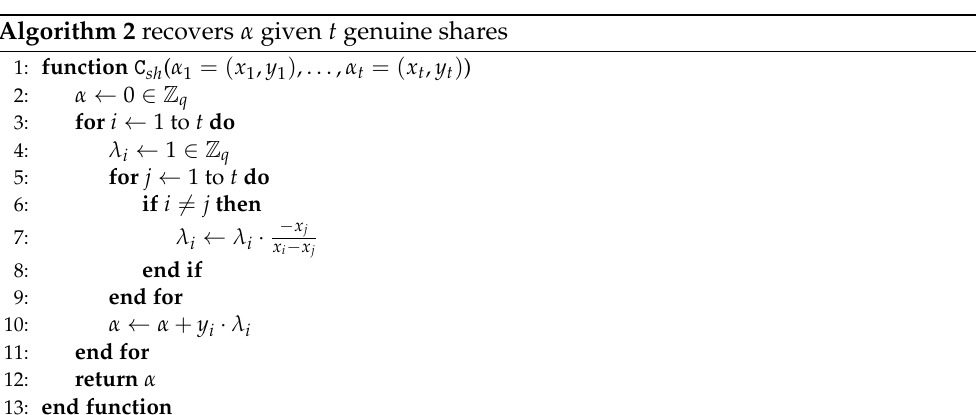
Algorithm 2 recovers α given t genuine shares